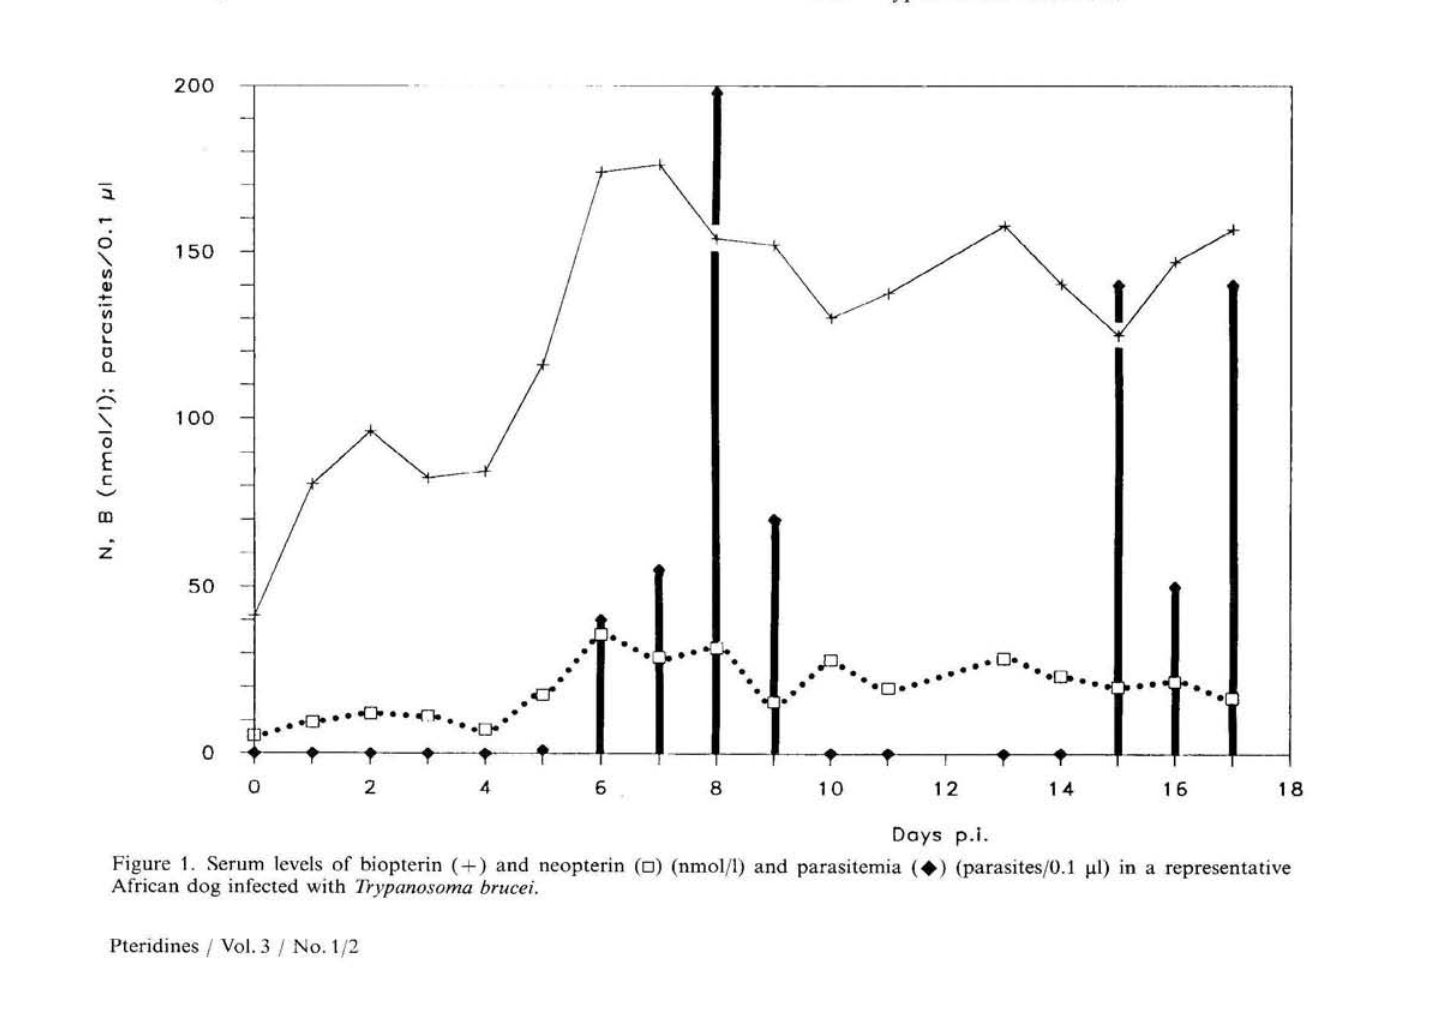
Figure 1. Serum levels of biopterin ( + ) and neopterin (•) (nmol/1) and parasitemia ( •) (parasites/0.1 μΐ) in a representative African dog infected with Trypanosoma brucei.